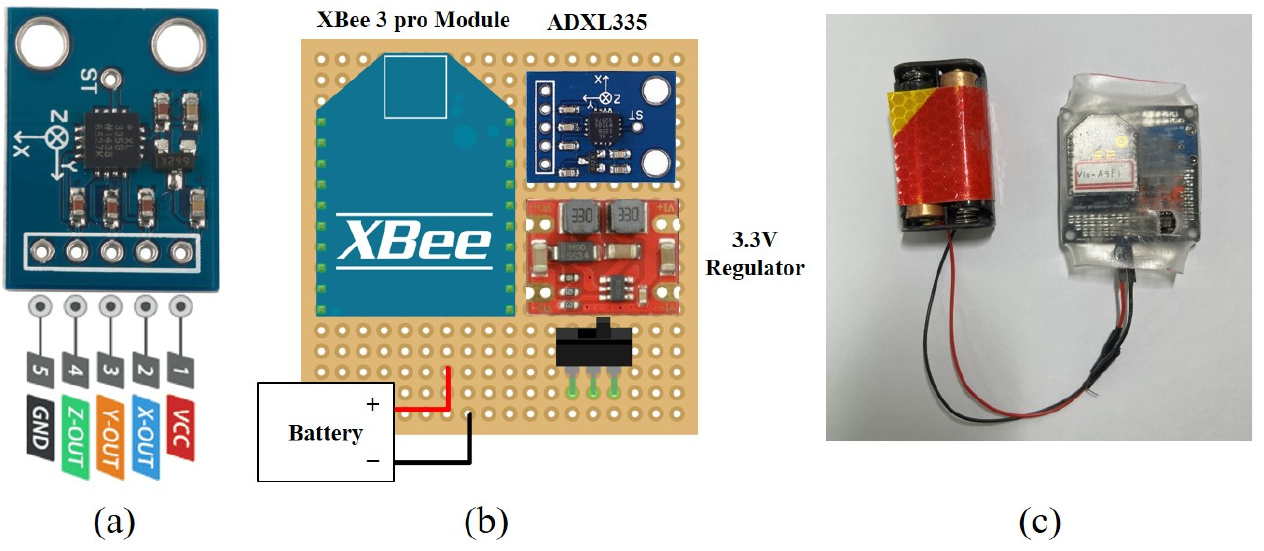
Figure 3. ( a ) ADXL335 accelerometer, ( b ) schematic, and ( c ) product of vibration measurement